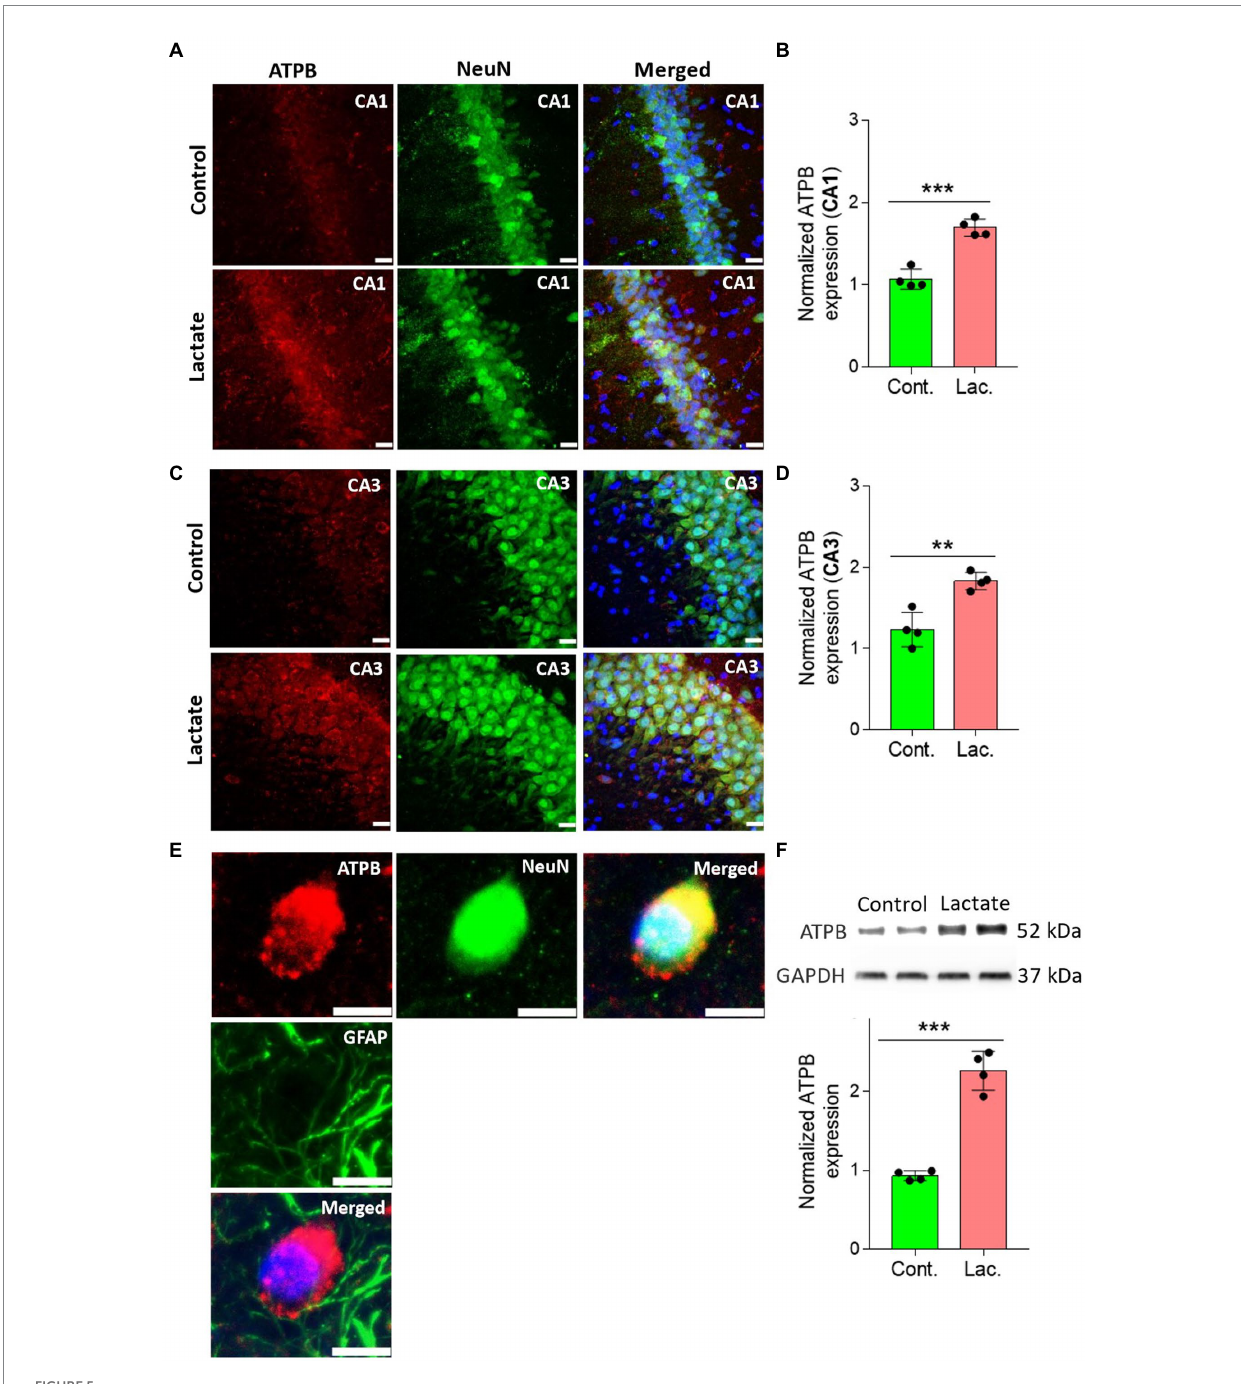
FIGURE 5 L-lactate increases ATPB expression in neurons of HPC. (A,C) Representative confocal micrograph of ATPB (red) co-labelled with NeuN (green) in the CA1 (A) and CA3 (C) areas of HPC of control and lactate groups. L-lactate infusion increased ATPB expression in both areas of HPC. Scale bars: 20 μ m. (B,D) Fluorescence intensity of ATPB stained sections in the CA1 (B) and CA3 (D) areas of HPC of lactate group was assessed and normalized to control group. Data are shown as mean ± SD ( n = 4 rats per group). p *** < 0.001, unpaired Student’s t -test. (E) Representative confocal micrograph of ATPB (red) co-labelled with GFAP (green) or NeuN (green) in the HPC of lactate group. Scale bars: 10 μ m. (F) Representative WB images of ATPB in the HPC extracts from control and lactate groups. Intensity of ATPB was quantified and normalized with GAPDH. ATPB was found to be significantly increased lactate group compared to control. Data are shown as mean ± SD ( n = 4 rats per group). p *** < 0.001, unpaired Student’s t